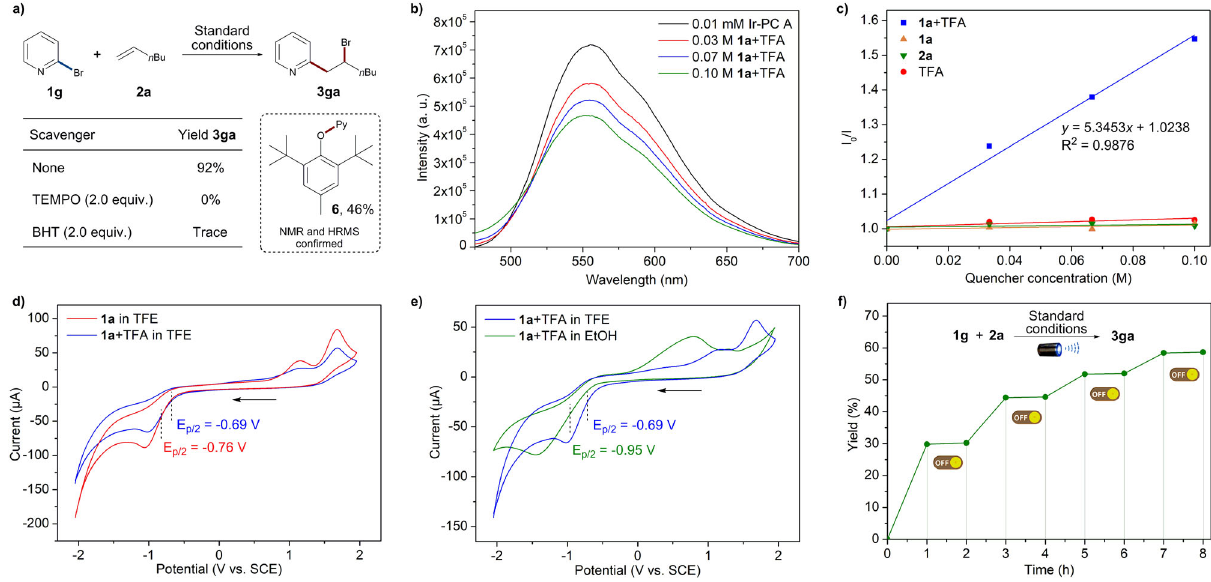
Fig. 3 Mechanistic investigations. a Radical trapping experiments. b Fluorescence quenching experiments of Ir-PC A with various concentrations of 1a + TFA in TFE solution. c Stern − Volmer plots of Ir-PC A with different quenchers. d Cyclic voltammograms of 1a and 1a + TFA in 0.1 M TBAPF 6 TFE solution. e Cyclic voltammograms of 1a + TFA in 0.1 M TBAPF 6 TFE solution and EtOH solution. f Light on/off experiments.